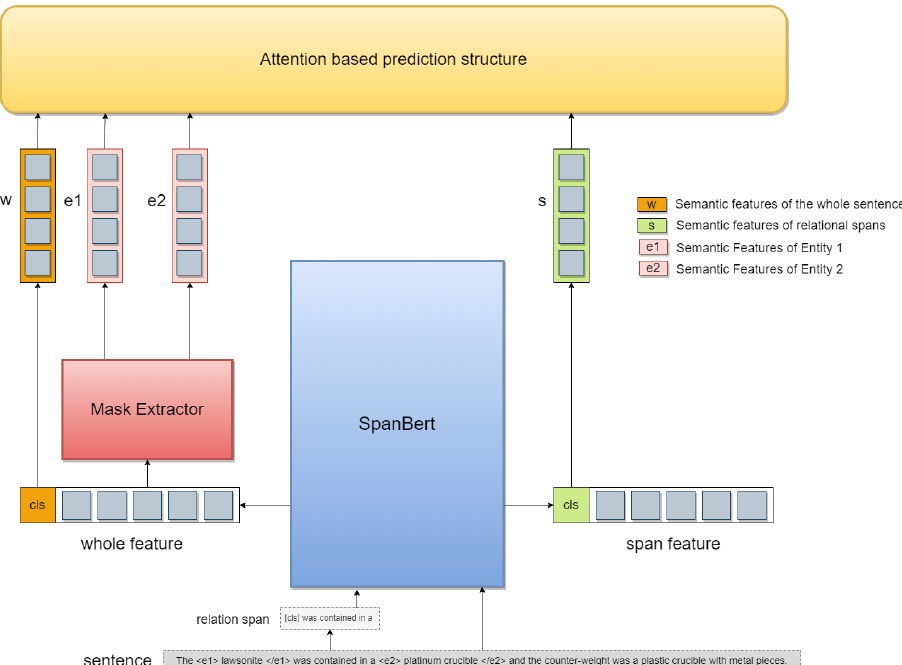
Figure 1. This is an overview of our model. When a sentence is an input, we extract the span of the relationship between entities by pre-processing and then send the span to BERT to extract features along with the sentence piece by piece. The features extracted from the sentence are passed through a mask extractor to extract the entity vector; eventually, w , e1 , e2 , and s are fed together into the prediction structure for predictive